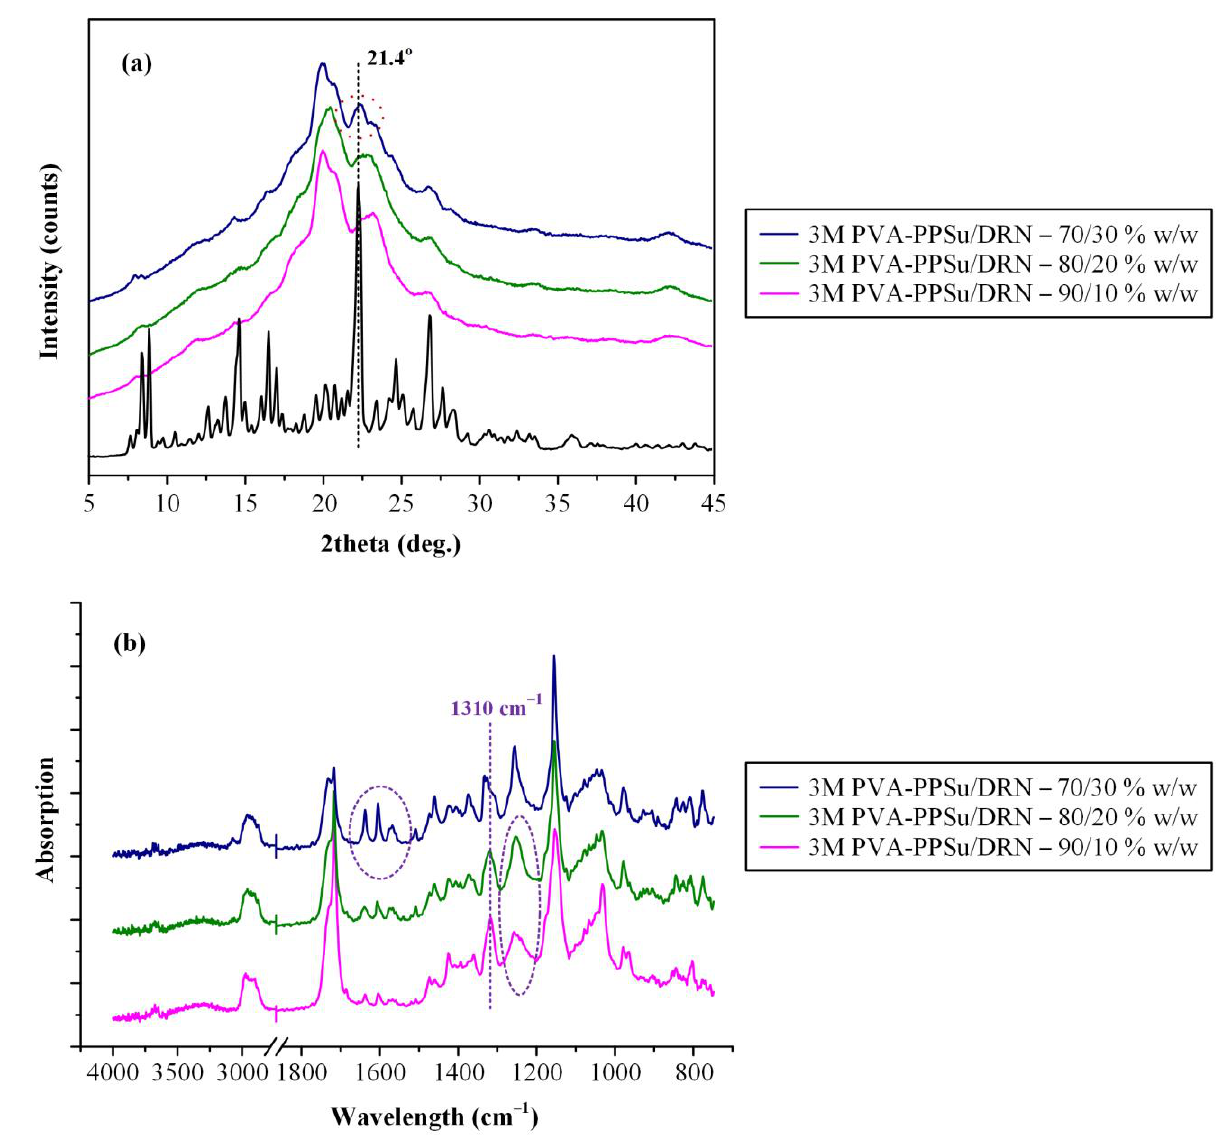
Figure 13. pXRD diffraction patterns ( a ) and ATR − FTIR spectra ( b ) of DRN-loaded PVA − PPsu ASDs after 3 months (3M) of storage.